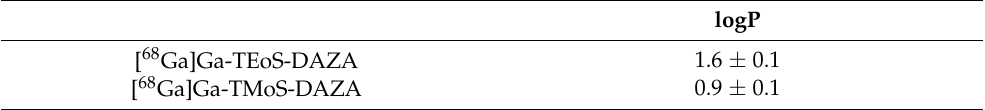
Figure 6. Biodistribution of [ 68 Ga]Ga-TEoS-DAZA and [ 68 Ga]Ga-TMoS-DAZA in ostrich embryos ( n = 7), given as mean values of %IA/g. The standard deviation is indicated by error bars. Table 2. Octanol-water-partition coefficient (logP) of [ 68 Ga]Ga-TEoS-DAZA and [ 68 Ga]Ga-TMoS- DAZA, as determined via a shake-flask-method.